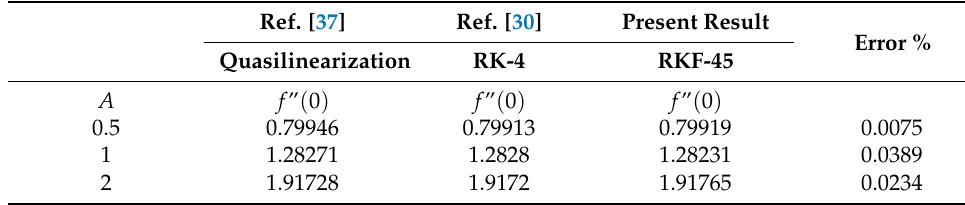
Table 5. Comparison of f ” ( 0 ) for several values of A in the absence of φ . Ref.